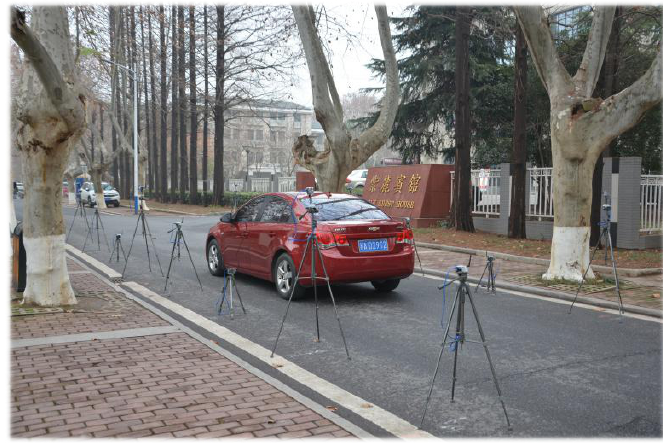
Figure 11. The layout of the